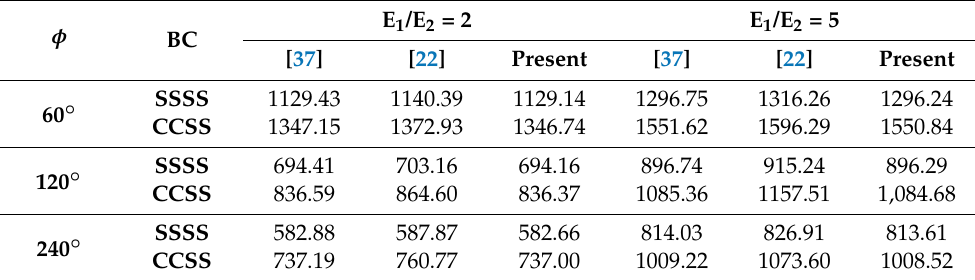
Table 1. Free vibration frequencies (in Hz) for three-layered (0 ◦ /90 ◦ /0 ◦ ) laminated, annular